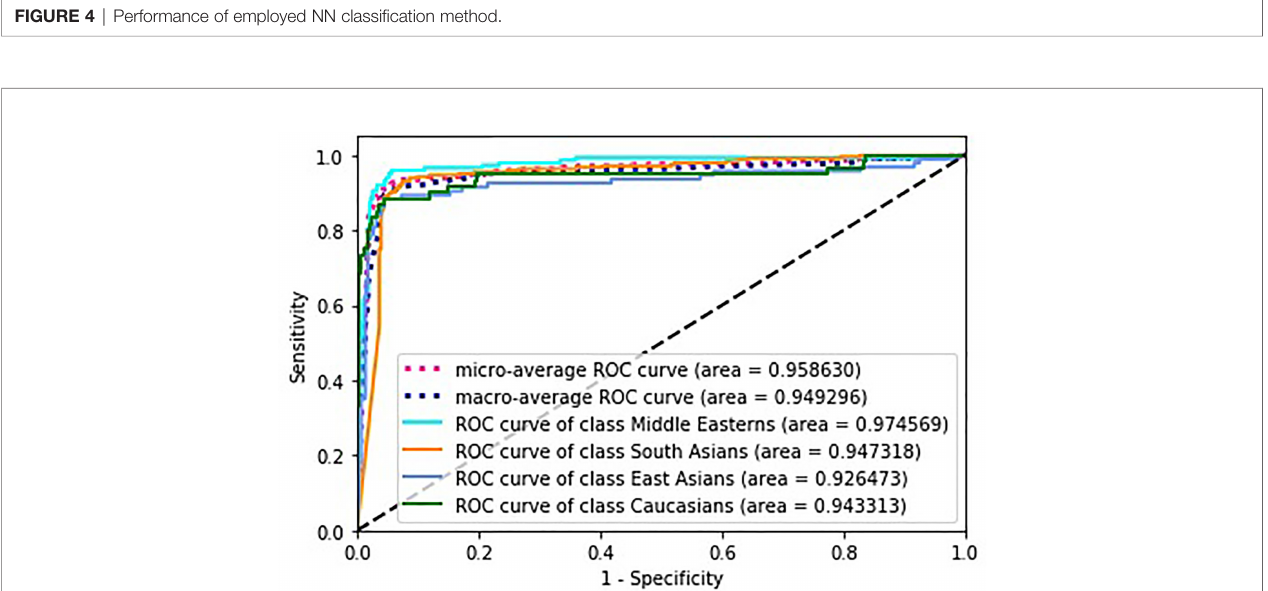
FIGURE 4 | Performance of employed NN classi fi cation method.